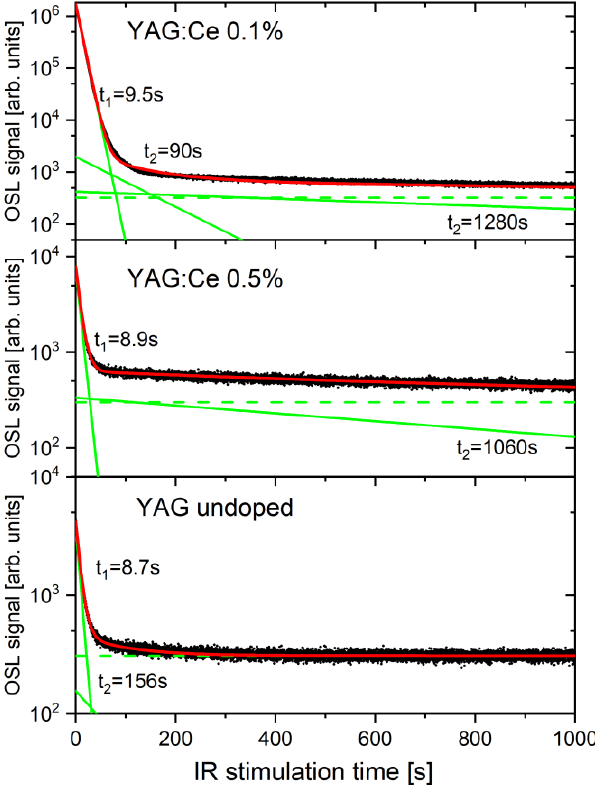
Figure 4. Decomposition of the decay curves of the YAG:Ce crystals into separate components (dose 2 Gy). The measured data (black dots) were fitted with exponential functions (solid green lines) plus a constant background (dash green lines). The sums of the fitted functions are represented by red